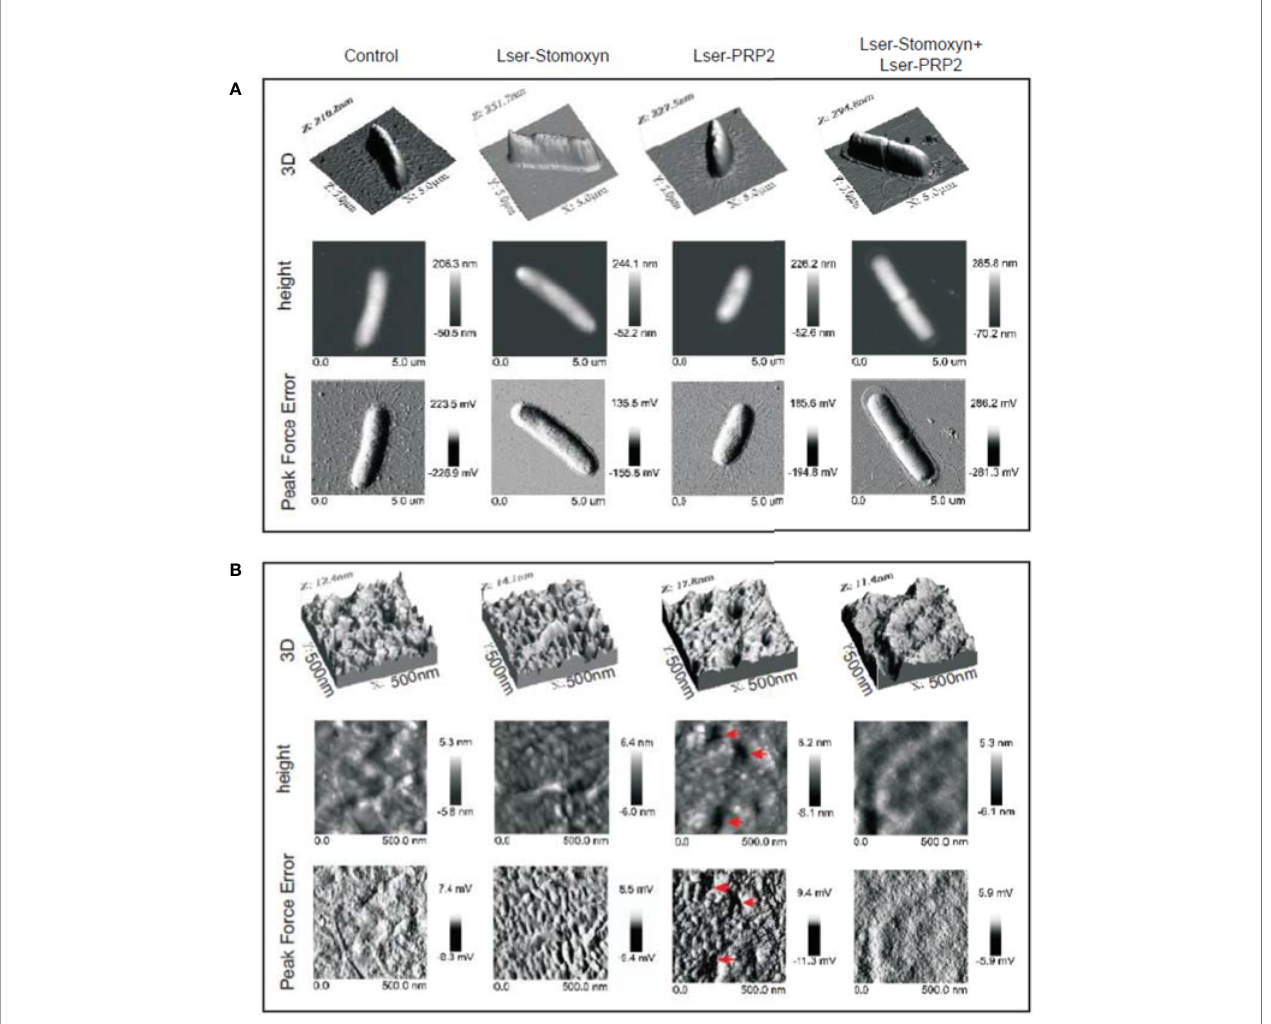
FIGURE 4 | Surface modi fi cations of Escherichia coli JM83 cells. The bacteria were incubated alone (control) or in the presence of Lser-stomoxyn (0.25 µM), Lser- PRP2 (50 µM), or a combination of both peptides, before imaging by atomic force microscopy. Three dimensional (3D), height and peak force error 5×5 µm (A) and 500×500 nm (B) images of the bacteria are presented. In (B) , the red arrows in the height and peak force error images indicate recesses observed after treatment with